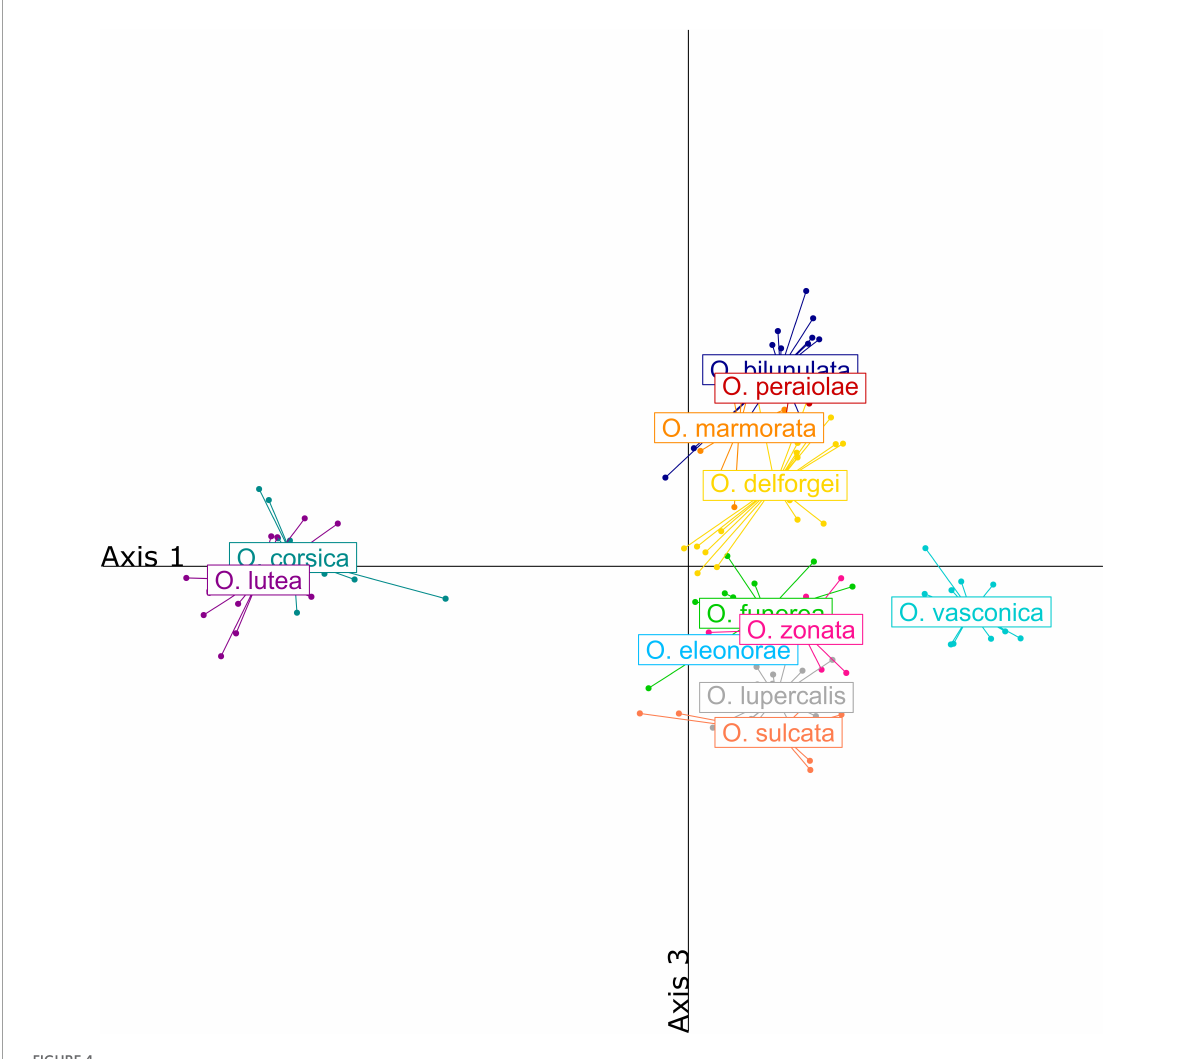
FIGURE4 Partial least squares-discriminant analysis (PLS-DA) of floral scents detected in the blends of the 12 French Pseudophrys taxa. Individuals were represented along axes 1 and 3 to better visualize variation within the O. fusca group.